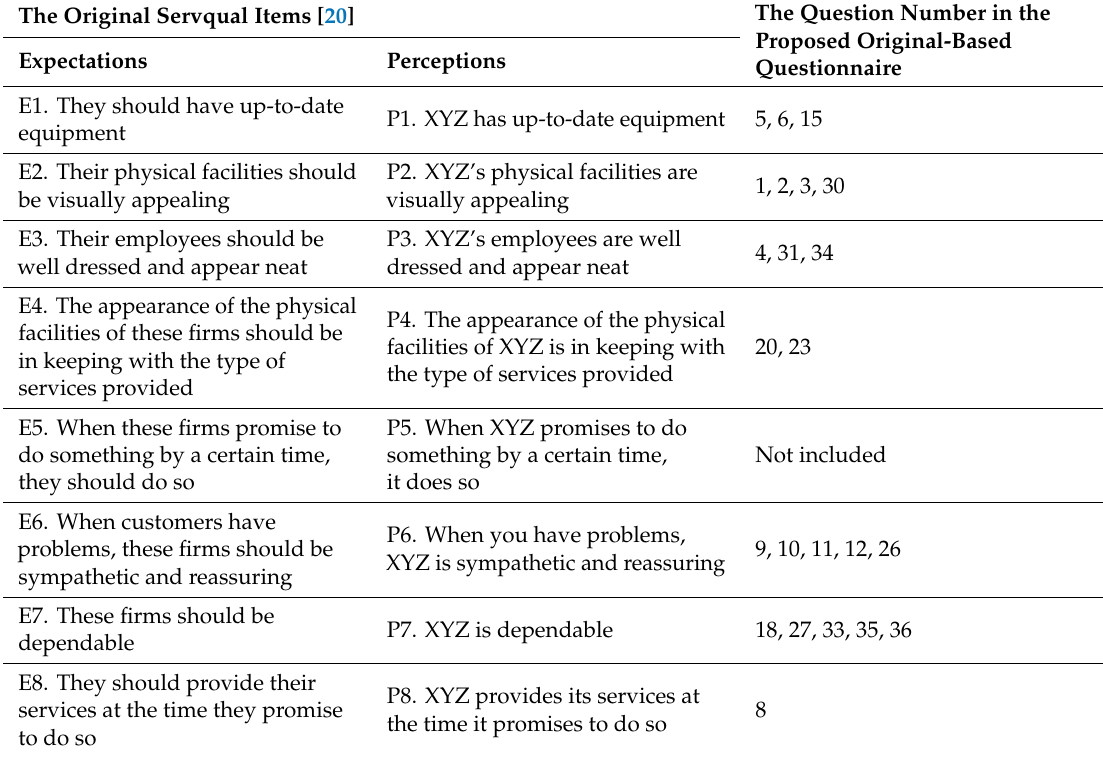
Table 3. Use of the original items in the construction and modification of questions for the subject of research. Own source based on